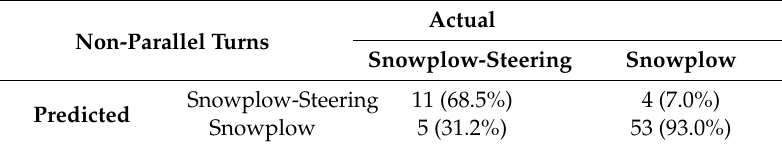
Table 11. Confusion matrix for non-parallel turns—Gradient boosted